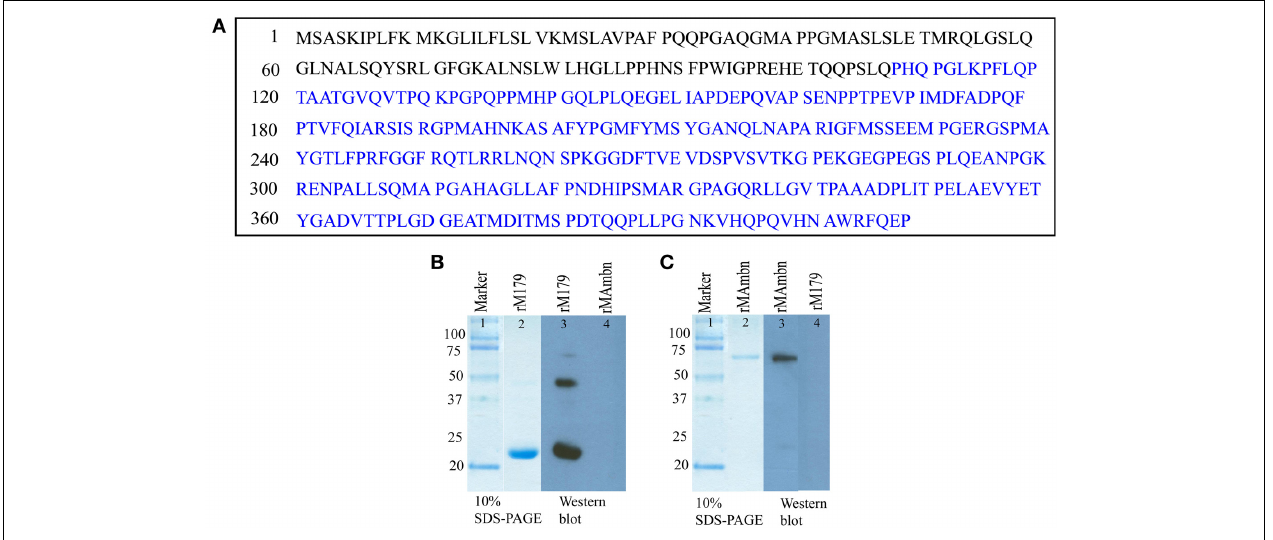
FIGURE 1 | (A) Sequence of full-length mouse ameloblastin (Gene ID: 11698), the epitope of anti-ameloblastin antibody M300 is indicated by blue color. Western blot analysis with (B) anti-amelogenin antibody (lane 3, 4) and (C) M300 antibody (lane 3, 4) to check cross reactivity of the antibodies with recombinant proteins.